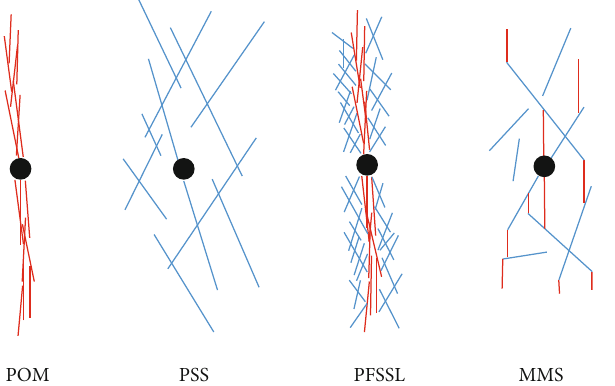
Figure 28: Four proposed stimulation mechanisms. The new HFs and the NFs are indicated by red and blue lines, respectively. The mechanisms are POM, PSS, PFSSL, and MMS [44].